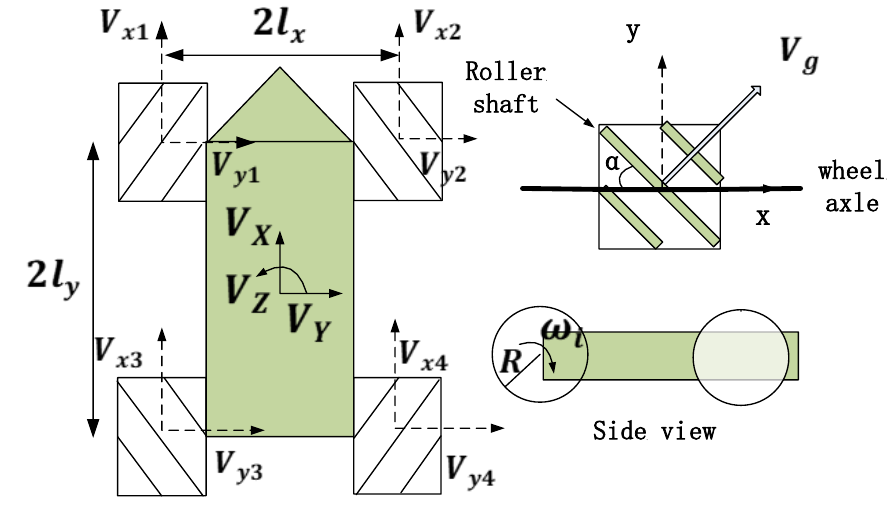
Figure 1. Structure diagram of